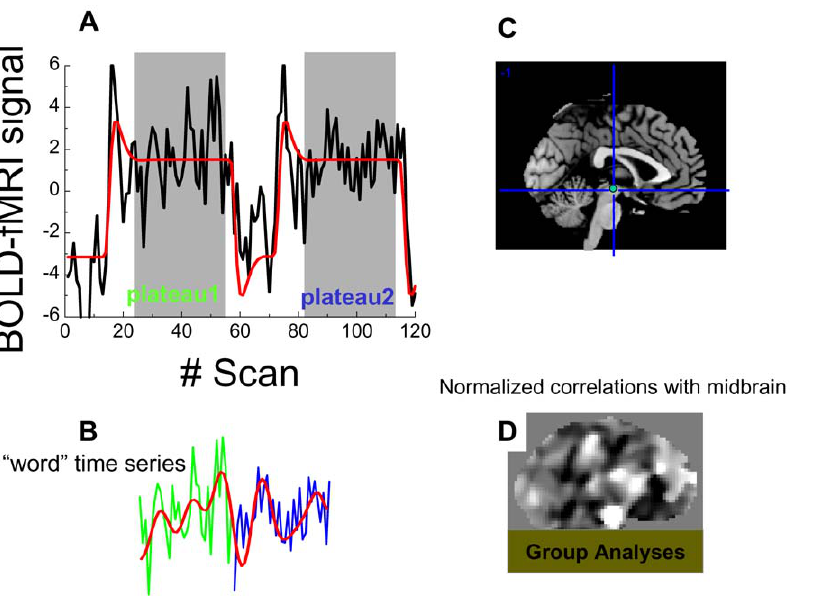
Figure 2. Functional connectivity analysis of task-related signal fluctuations during the blocked fMRI paradigm. A : BOLD response elicited by the drug-word paradigm (black curve) and the fitted SPM2 canonic hemodynamic response (red curve). The gray periods identify the plateaus of the model. B : ‘‘Word’’ time series are composed by 37 the time points of plateau 1 (green curve) and the 37 time points of plateau 2 (blue curve). C : Mid-sagittal slice of an MRI structure showing the position of the midbrain seed used for the functional connectivity analysis. D: Mid- saggital slice exemplifying the normalized (z-score) maps reflecting correlations of MRI signals in the brain with those in midbrain. These individual maps were used in group analyses of functional connectivity.